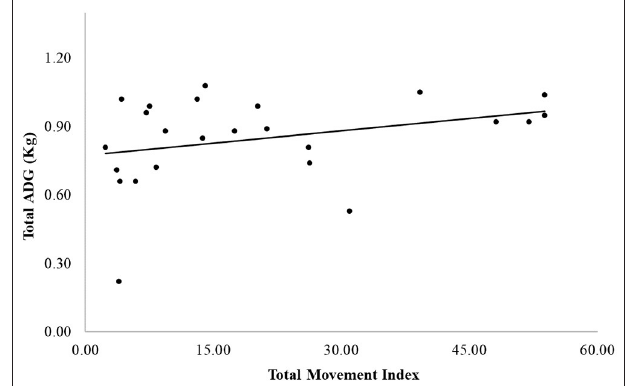
FIGURE 6 | Distribution of individual calf average daily gain (ADG) from birth until 2-weeks after weaning (Total ADG) plotted against each the total movement index from the isolation box test. The linear regression trendline is presented for the plot (solid black line = significant regression, P < 0.05; dashed line = non-significant regression, P >